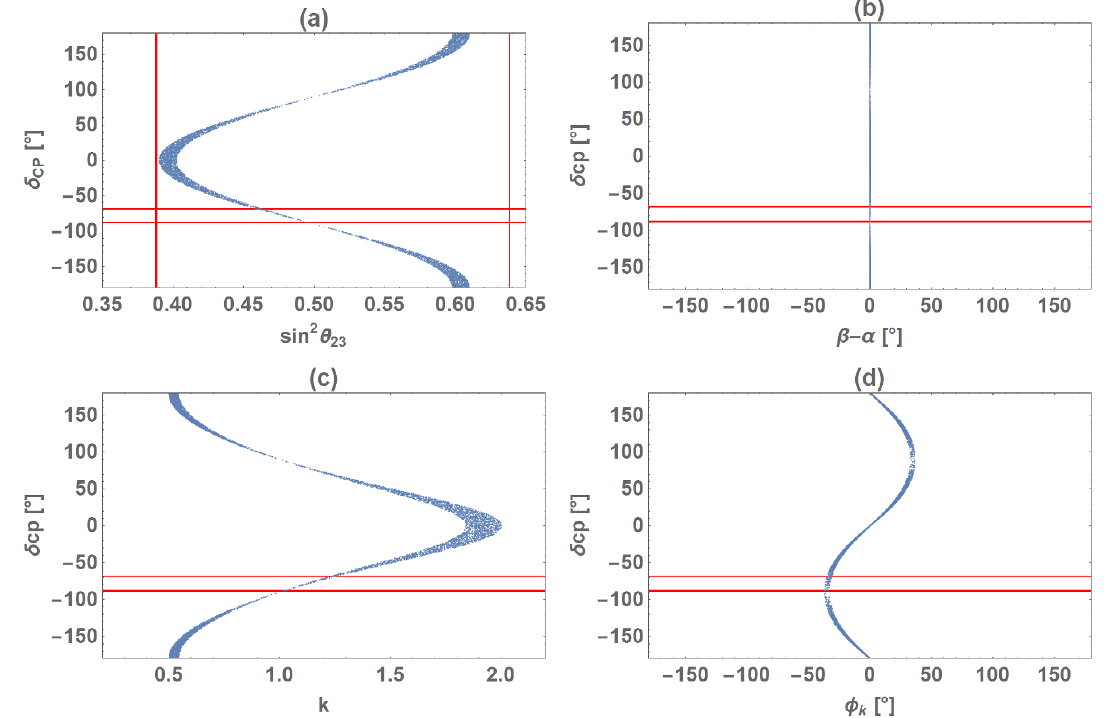
Figure 8 . Predictions for TM 2 in IH, where the red lines for sin 2 (cid:18) 23 and (cid:14) CP denote the experi- mental bounds of 3 (cid:27) (global analyses) and 2 (cid:27) (T2K), respectively: (a) (cid:14) CP versus sin 2 (cid:18) 23 , (b) (cid:14) CP versus di(cid:11)erence of two Majorana phases (cid:12) (cid:0) (cid:11) , (c) (cid:14) CP versus k , and (d) (cid:14) CP versus (cid:30) k . Our 3 (cid:2) 2 Dirac neutrino mass matrix is reproduced by introducing gauge singlet (cid:13)avons with the VEV’s in S (cid:13)avor symmetry. The speci(cid:12)c alignments of the VEV’s 4